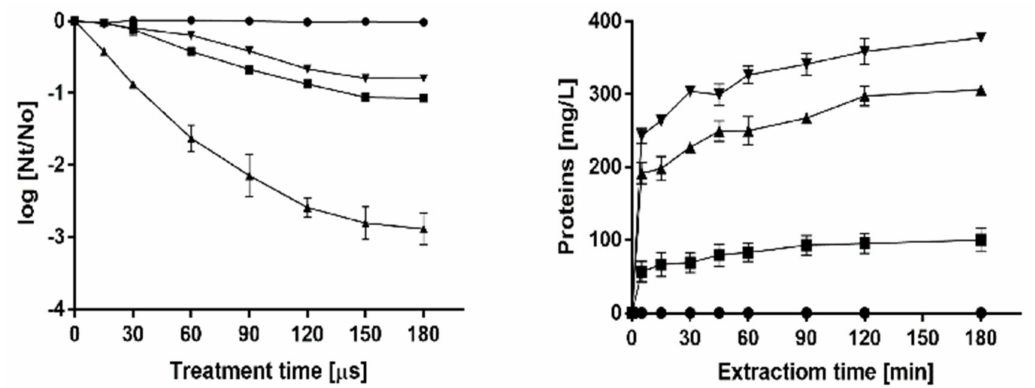
Figure2. OptimizationofintracellularSM3GRNLY(iSM3GRNLY)productionfrom P.pastoris. Leftpanel: inactivation of Pichia pastoris by pulsed electric field (PEF) treatment of di ff erent electric field strengths. Treatment of 8 kV / cm ( • ), 12 kV / cm ( (cid:72) ), 16 kV / cm ( (cid:4) ), 20 kV / cm ( (cid:78) ). Right panel: e ff ect of di ff erent electric field strengths in intracellular protein extraction. Treatment of 12 kV / cm ( (cid:4) ), 16 kV / cm ( (cid:78) ), 20 kV / cm ( (cid:72) ) and control ( •